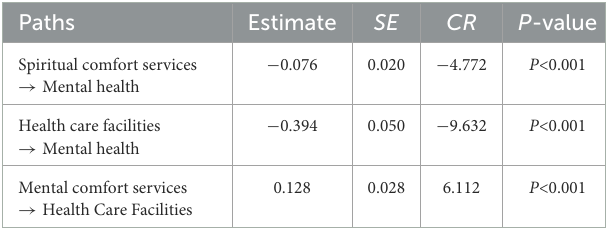
TABLE 6 Structural equation model estimation results.